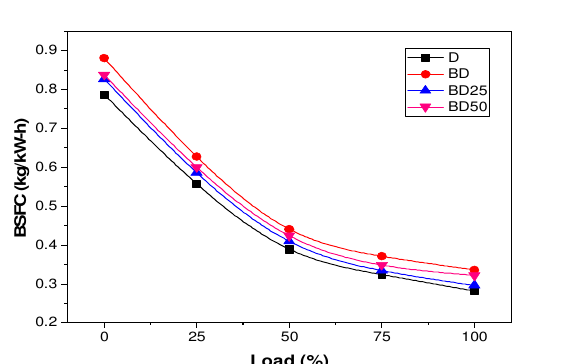
Fig. 4: Influence of engine load on BSFC with diesel and Jatropha biodiesel blends